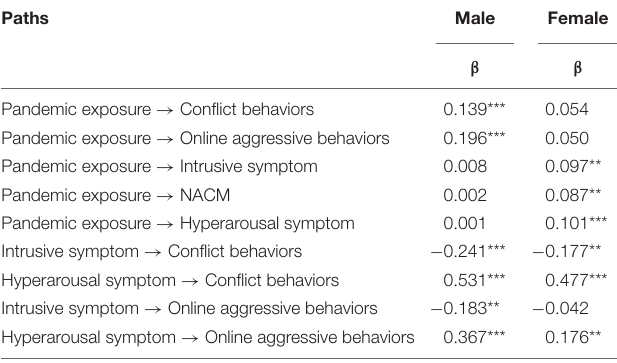
TABLE 2 | Path coefficients in male and female